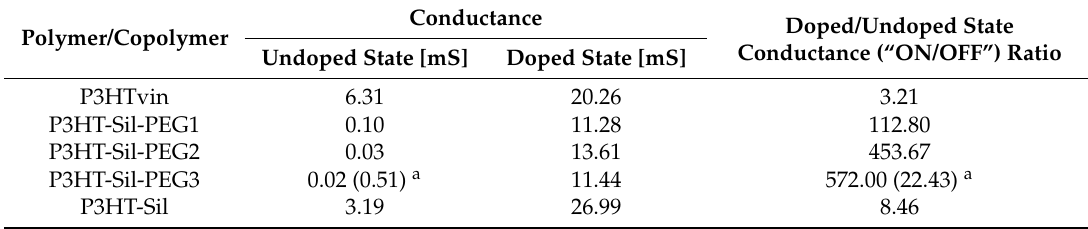
Table 3. “ON/OFF” conductance ratios of the investigated polymer